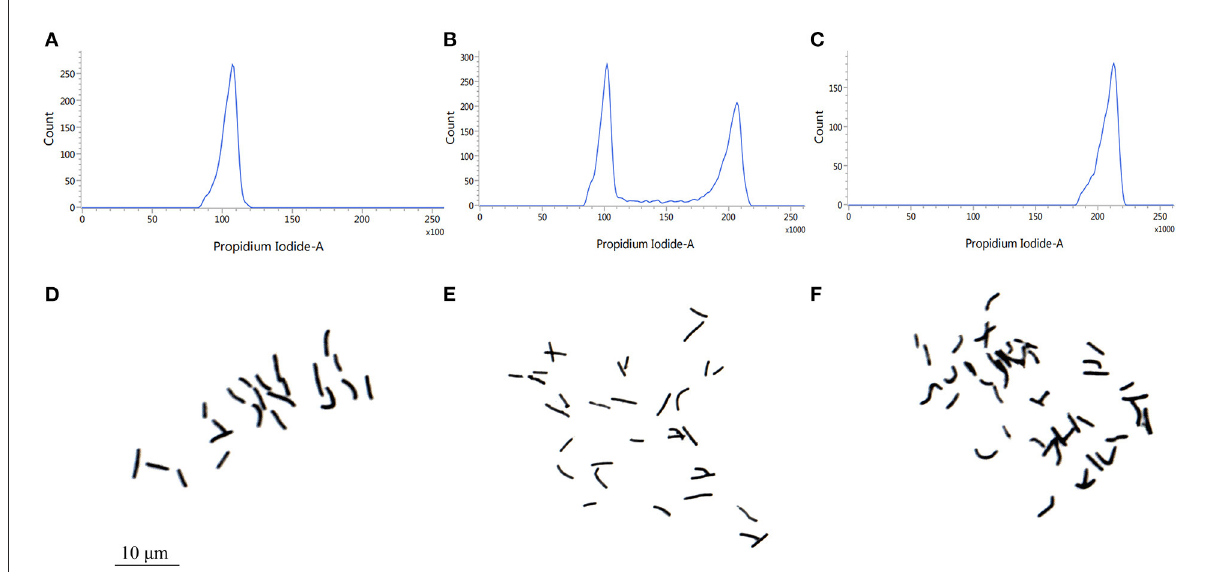
FIGURE1 Ploidy analysis of of Pisang Berlin (AA). (A) DNA content of diploids (the main peak at channel 100). (B) DNA content of triploids (the main peak at channel 100–200). (C) DNA content of autotetraploid (the main peak at channel 200). (D) Chromosome number of diploids (2n = 2X = 22). (E) Chromosome number of triploids (2n = 3X = 33). (F) Chromosome number of autotetraploids (2n = 4X =